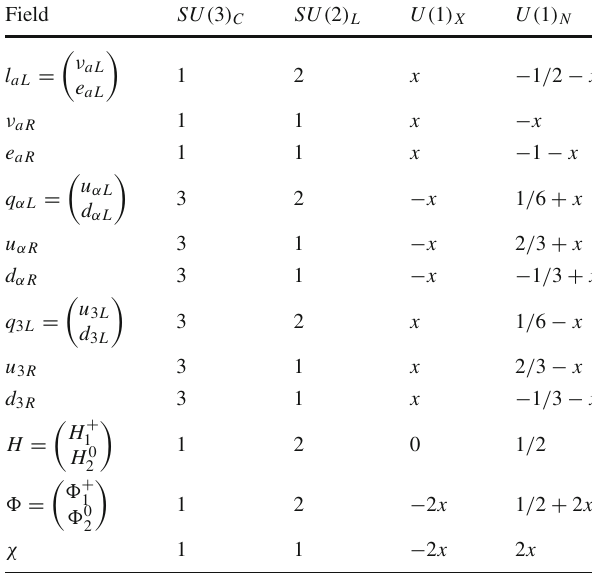
Table 1 Field representation under the gauge symmetry